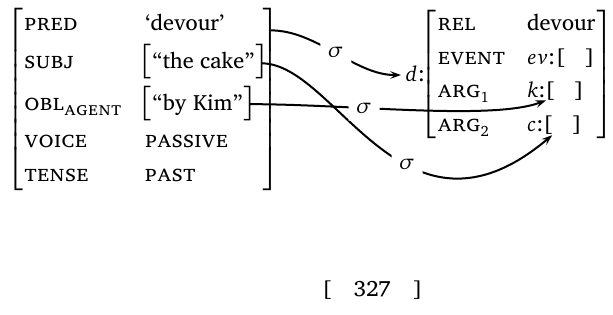
Figure 5: Structures and correspondences for The cake was devoured by